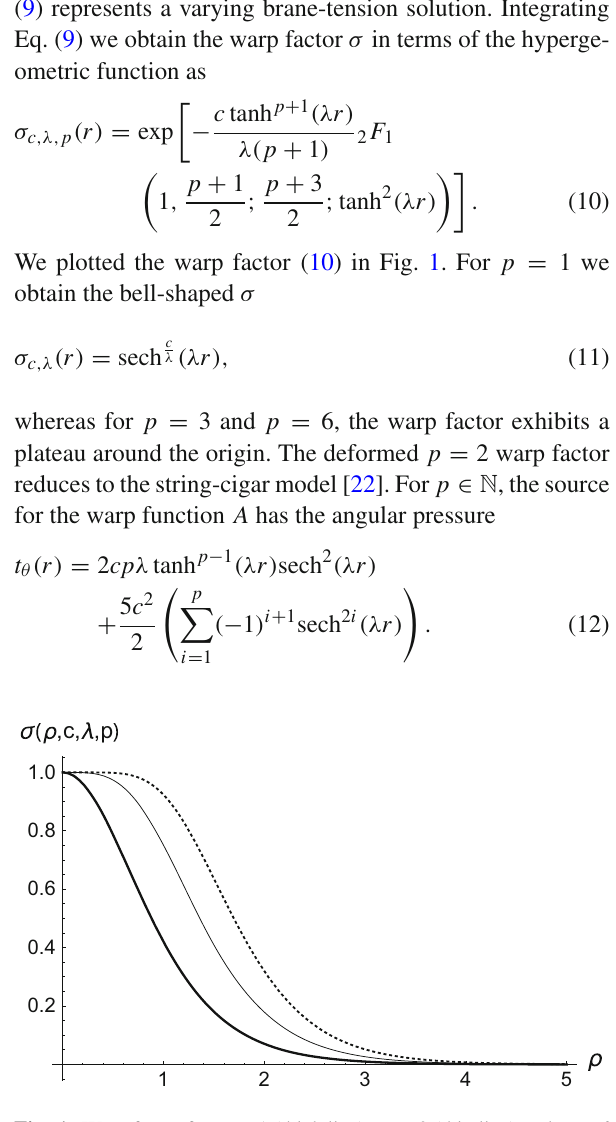
Fig. 1 Warp factor for p = 1 (thick line), p = 3 (thin line) and p = 6 (dotted